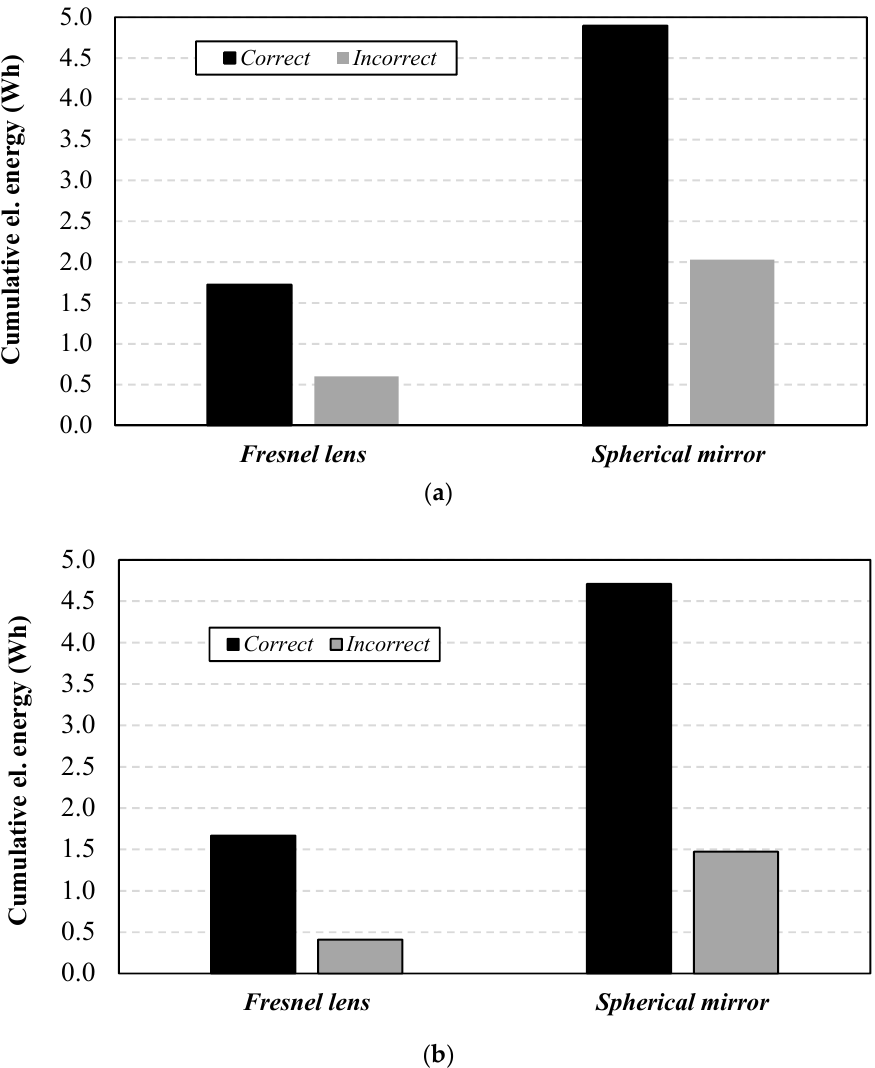
Figure 14. Cumulative electrical energy produced in the cases of correct and incorrect solar tracking for the two optics in the cases with ( a ) and without ( b ) secondary optics.